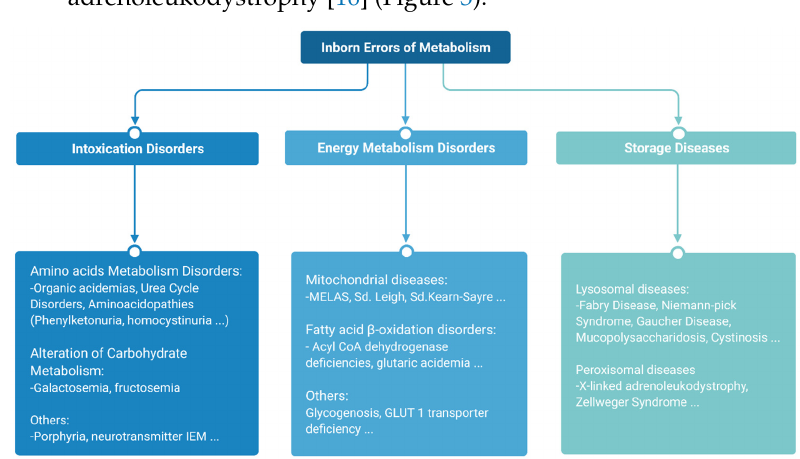
Figure 3. IEM classification according to symptoms.